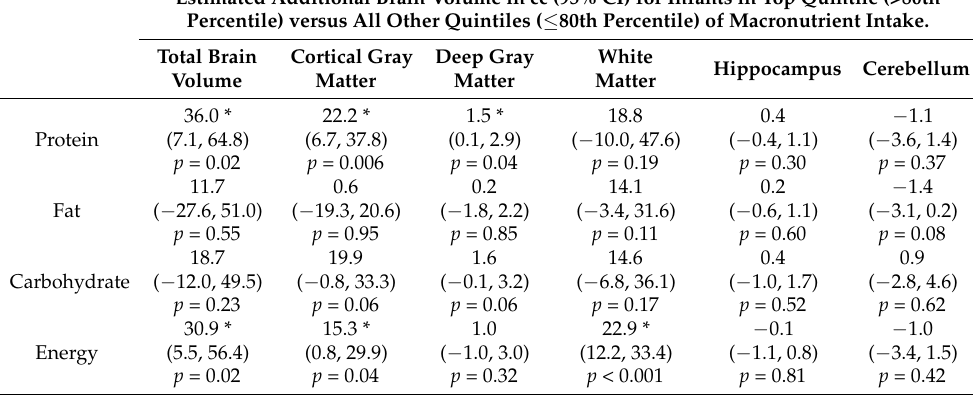
Table 3. Associations of macronutrient intake with brain volume at term equivalent age ( n = 42).